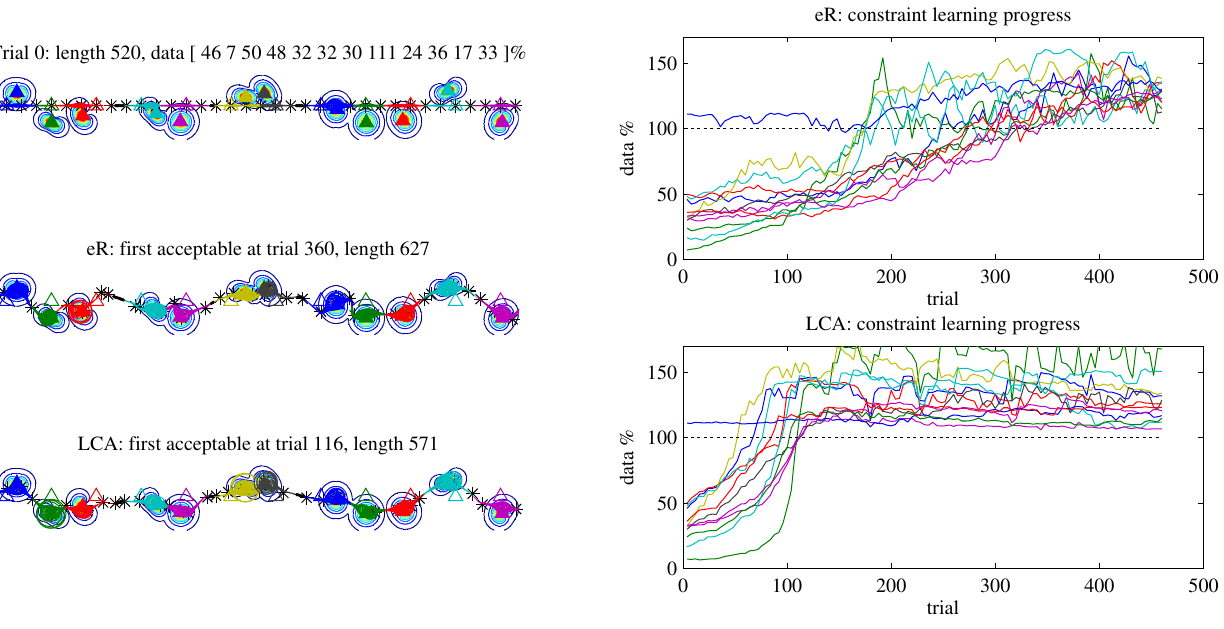
Figure 5. LCA vs . eR: sample trajectories for 12 sensors. Left column, from top to bottom: the initial trajectory is assumed to follow that of a deployment aircraft’s recorded path and is ignorant of actual sensor positions (deployed every 30 units, displaced uniformly randomly on a circle of radius 12 around the expected location); the first acceptable trajectory learned by eR; and the trajectory produced by LCA after the same number of steps. “Length” for the learned trajectories is the average length over the 100 trials after the first acceptable trajectory is discovered. Right column: fraction of the data requirement fulfilled (here req = 25 for each node); each line shows the trace of data collected vs. trial number for a single node, for eR and LCA. Here we use 38 waypoints (76 parameters) for 12